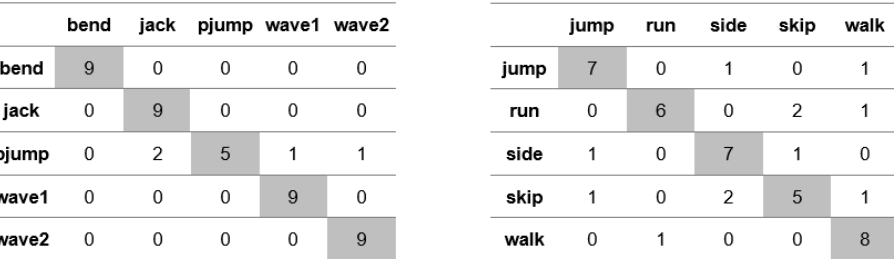
Figure 5. Confusion matrices for the best experiment using the ‘lower-occlusion’ database. ( Left ta- ble ): ‘actions performed in place’ subgroup, Elongation, C1 correlation, 55 DFT coefficients, accuracy 91.11%. ( Right table ): ‘actions with changing location of a silhouette’ subgroup, ShorterMBR, C1 correlation, 71 DFT coefficients, accuracy 73.33%.